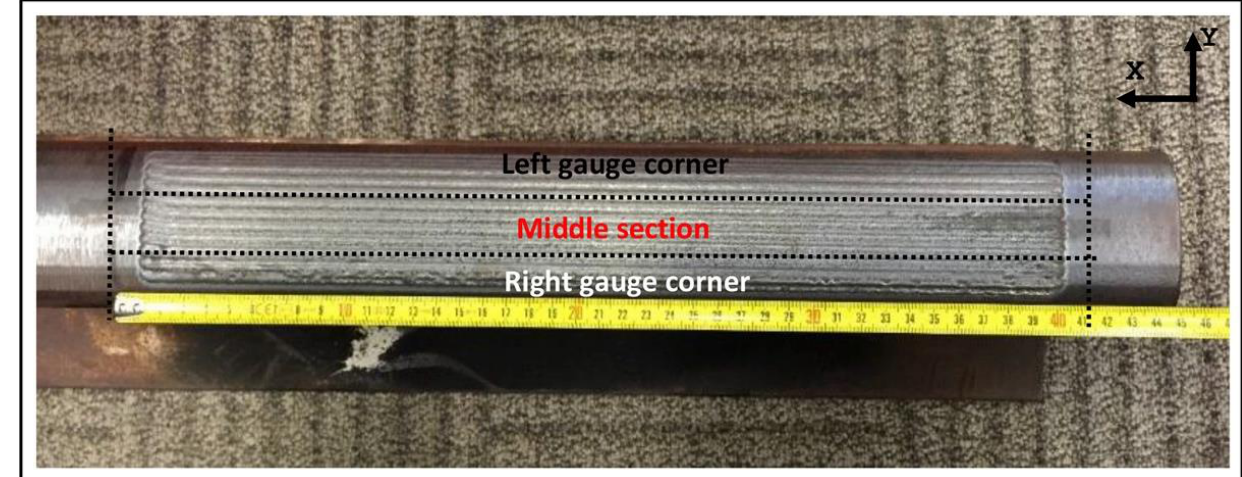
Figure 16. Cladding on hypereutectoid railway steel. Reproduced with permission from [22]. Copyright Elsevier, 2017.